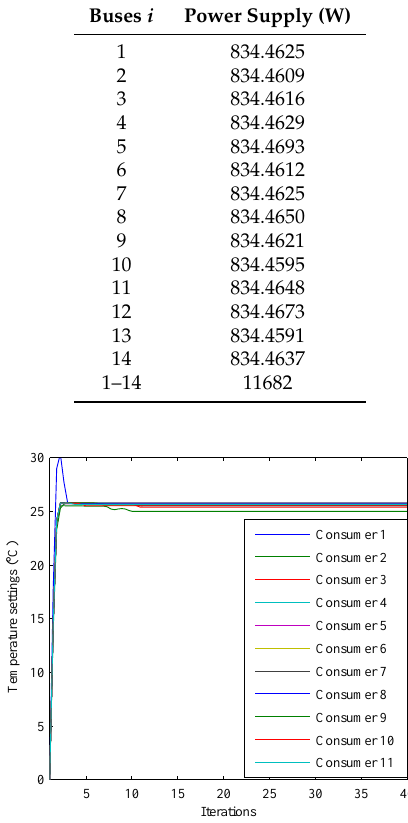
Figure 11. The convergence of the temperature settings.